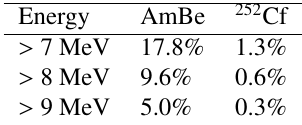
Table 2. Share of fast neutrons.